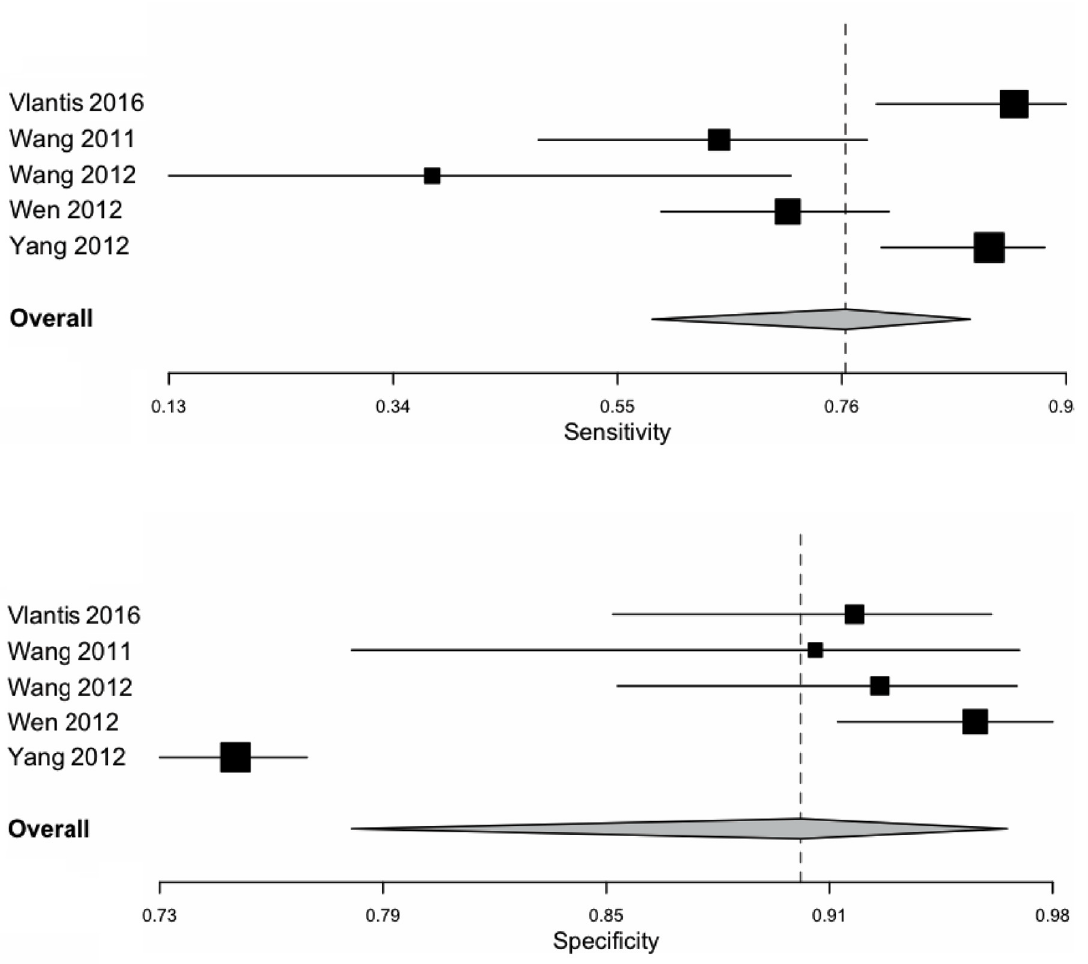
Figure 3. White light endoscopy sensitivity and specificity forest plots summarized the individual as well as the pooled sensitivities and specificities for nasoendoscopy with conventional white light settings.